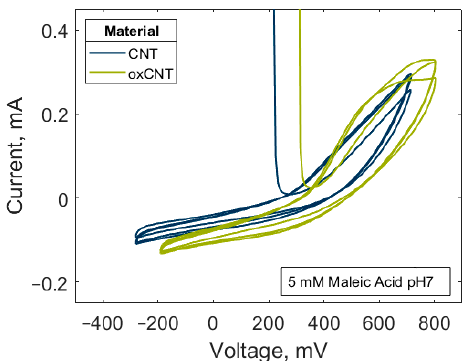
Figure 8. Cyclic voltammetry of untreated and oxidized CNT-K monoliths.